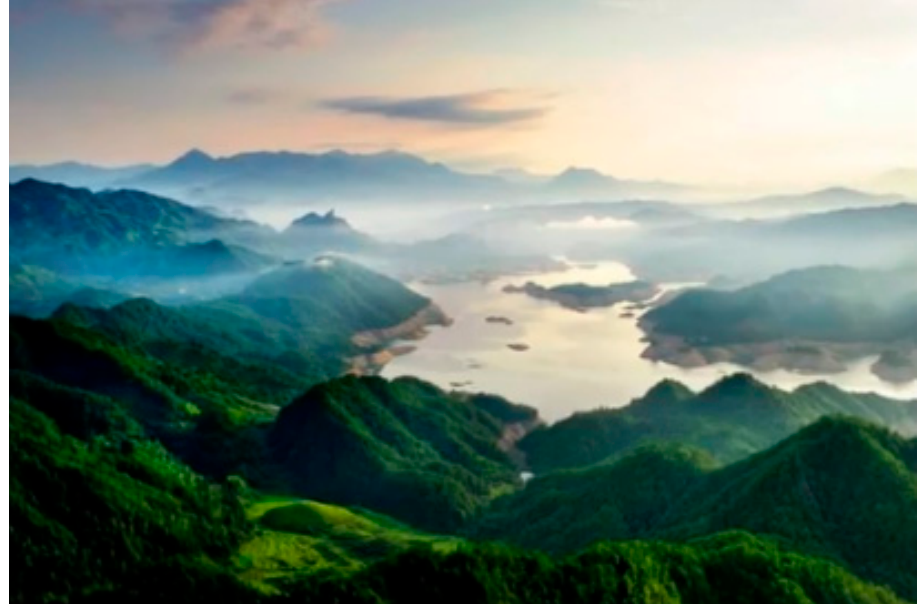
Figure 1. Illustration of a forest.